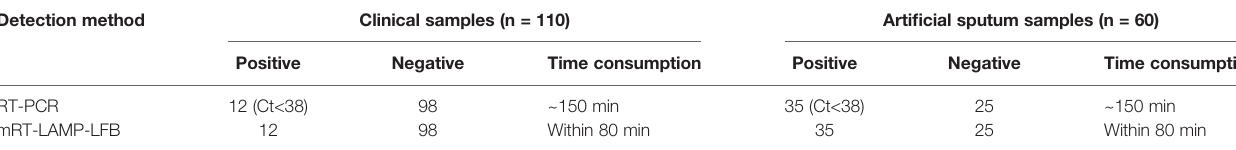
TABLE 3 | Comparison of RT-PCR and mRT-LAMP-LFB methods to identify SARS-CoV-2 in clinical samples and arti fi cial sputum samples. Detection method Clinical samples (n =